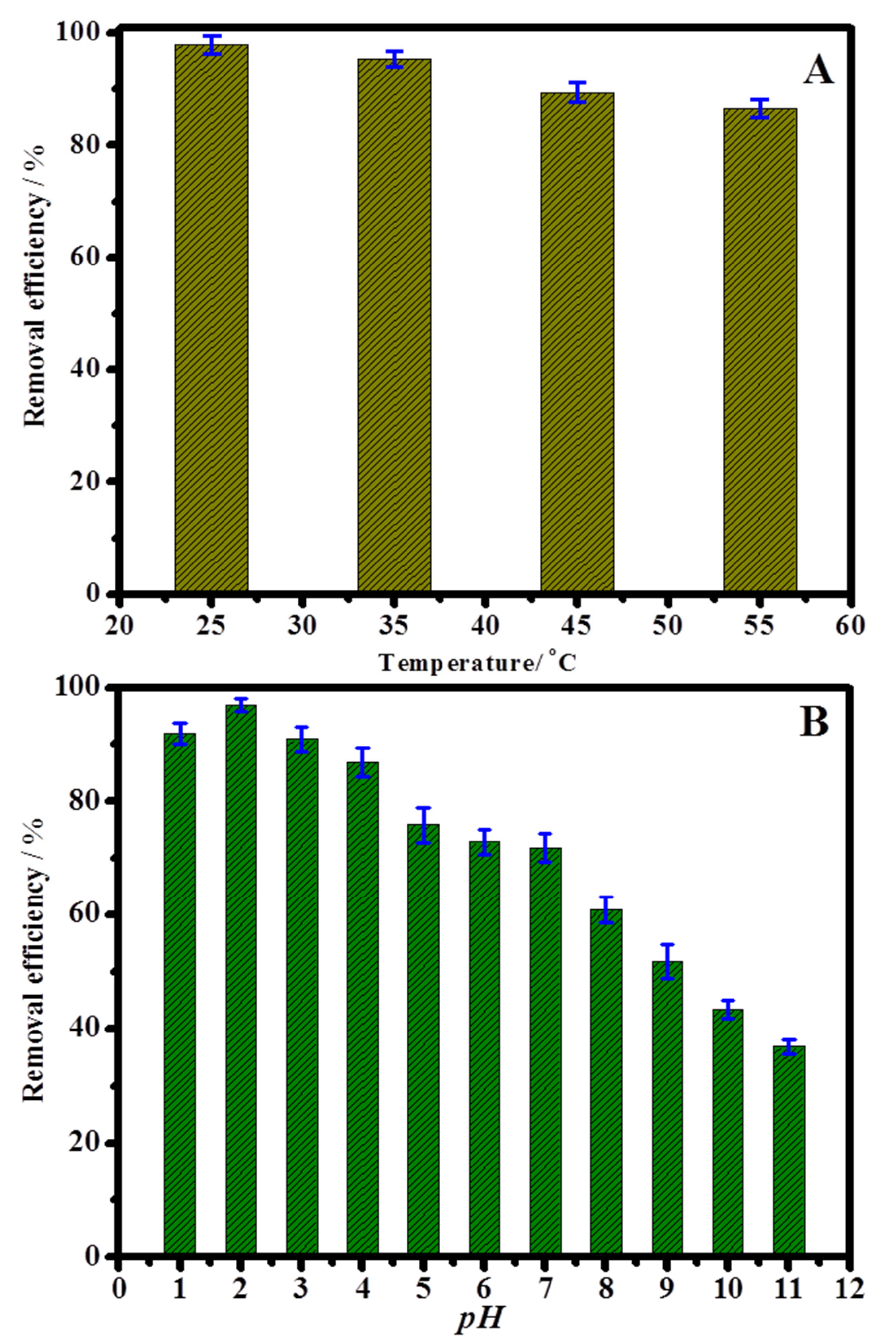
Figure 4. Effect of temperature (pH = 2) ( A ) and pH ( B ) on the on the removal efficiency (adsorption) of Cr (VI) by Fe(0)@AC; 0.6 g of Fe(0)@AC, 100 mg/L Cr(IV), adsorption time = 90 min.